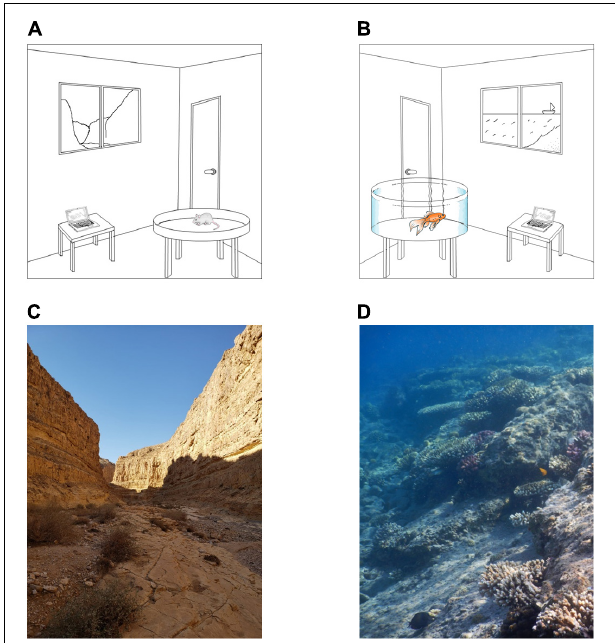
FIGURE 1 | Lab versus natural environments. (A,B) Illustration of artificial lab environments for rodents and fish. The lab setting is restricted in terms of size, navigational cues, and complexity. (C,D) Two examples of natural environments for terrestrial and aquatic environments. The environments are limitless, rich in cues needed for navigation, and very